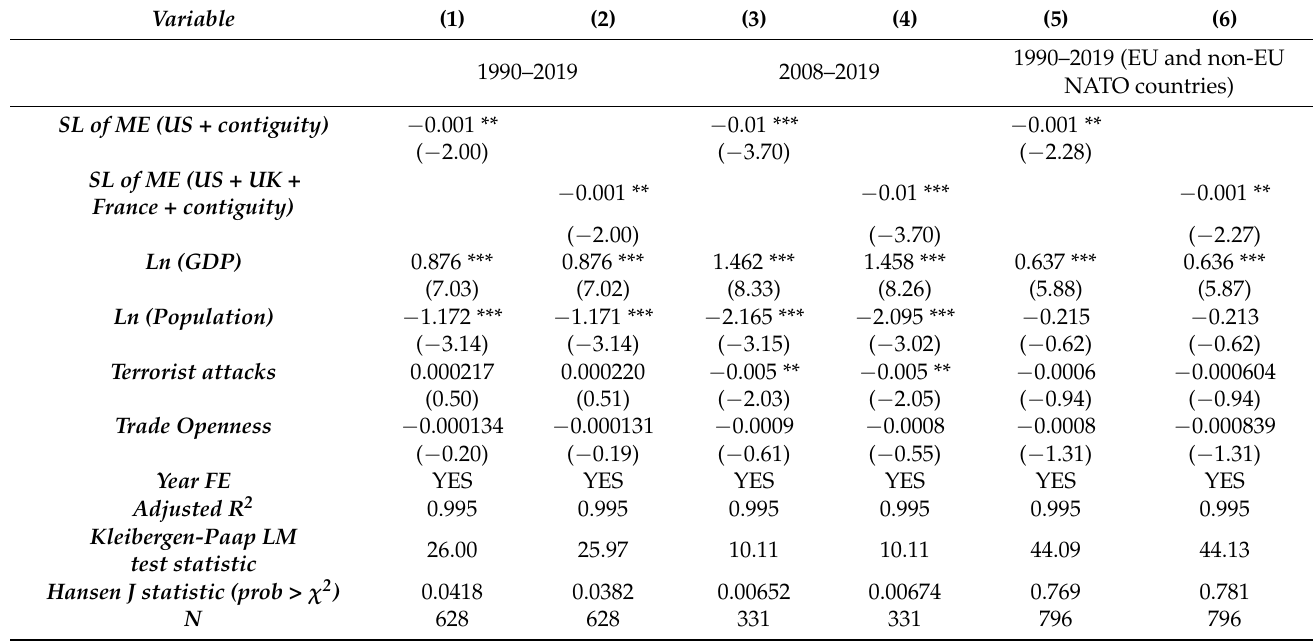
Table 4. EU military expenditure, 1990–2019 (Alternate spatial